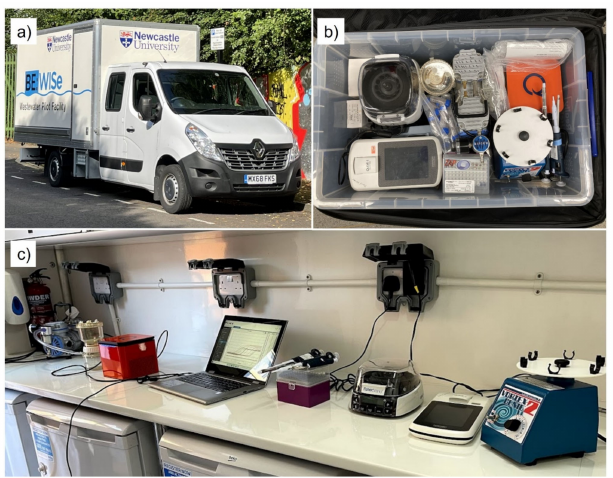
Figure 1. ( a ) Mobile laboratory in the back of a van; ( b ) the equipment items needed for onsite marker gene quantification inside a suitcase for transportation, and ( c ) the equipment items set up on the bench of the mobile laboratory, from left to right: vacuum pump, filtration unit, qPCR instrument, laptop computer, pipettes and tips, centrifuge, fluorometer, and vortex with adapter. For the 16S rRNA gene qPCR assay, the reaction mixtures were prepared as follows: 2 µ L of the DNA samples, 7.5 µ L of SsoAdvanced™ Universal Inhibitor-Tolerant SYBR ® Green Supermix, 4 µ L of nuclease free water (Thermo Fisher Scientific, Loughborough, UK), and 0.75 µ L of each forward and reverse primer solutions (@ 10 micromol · L − 1 ) were combined for a 15 µ L final volume with 500 (nmol · L − 1 ) of each primer. For the rodA probe-based reactions, we used 2 µ L of DNA samples, 5 µ L of PerfeCTa ® qPCR ToughMix ® (Quantabio, Beverly, MA, USA), 1.75 µ L of nuclease free water (Thermo Fisher Scientific, Loughborough, UK), 0.25 µ L of the probe solution (@ 10 micromol · L − 1 ), and 0.5 µ L of each forward and reverse primer solutions (@ 10 micromol · L − 1 ) for 10 µ L of final volume with 500 (nmol · L − 1 ) of each primer and 250 (nmol · L − 1 ) of the probe. All the standards,